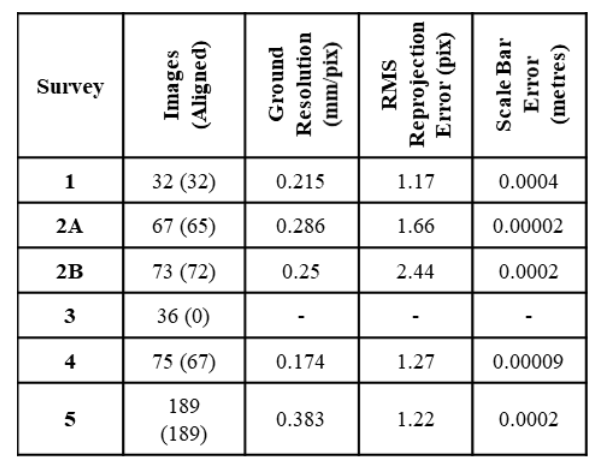
Table 1. SfM Field Survey Statistics